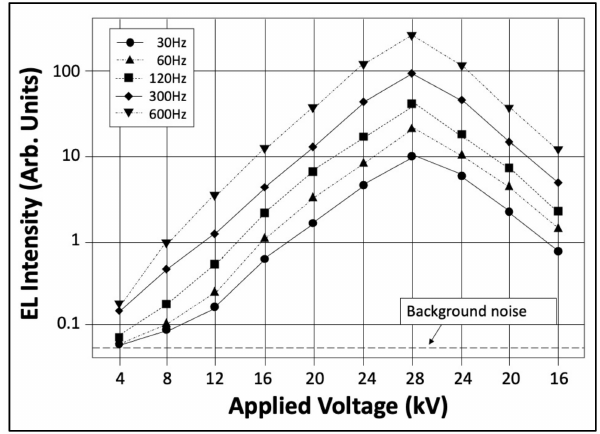
Figure 1. The electroluminescence intensity behaviour as a function of applied voltage. Reprinted with permission from ref. [26]. Copyright 2002 IEEE.